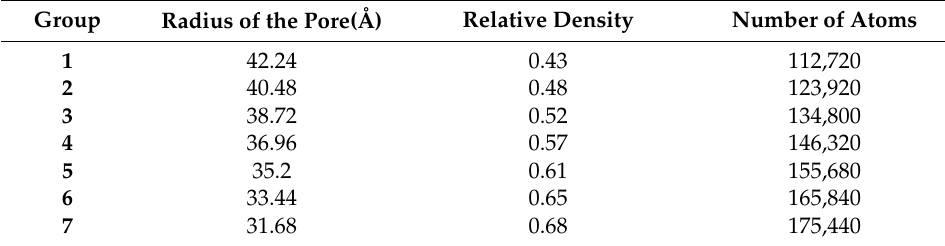
Figure 1. ( a ) Perspective view and ( b ) In-plane (top) view ( x-y plane) of representative volume elements (RVE) for highly ordered nanoporous nickel (HONN); and in-plane views for CNT-reinoforced HONNs(CNHONNs) with ω CNT of ( c ) 1.28‰, ( d ) 2.58‰, ( e ) 3.89‰ and ( f ) 5.22‰. Table 1. Parameters of RVEs of HONNs.